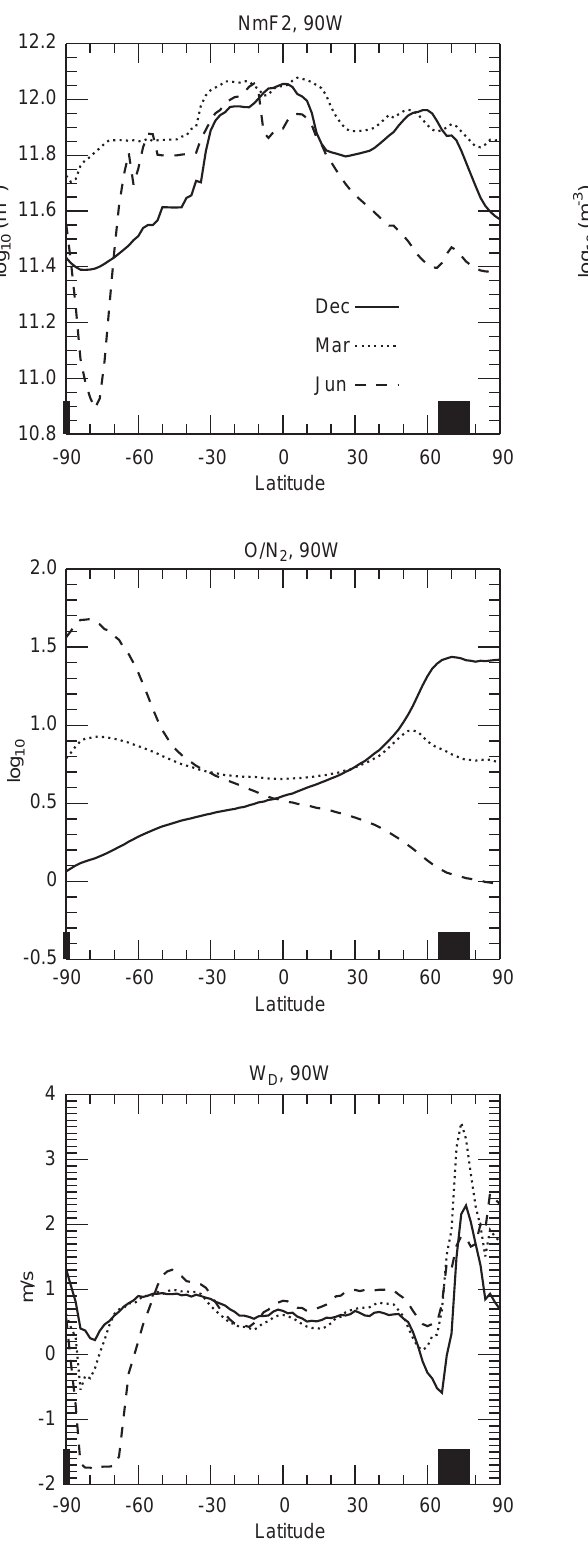
90 (cid:14) E and the southern oval at 90 (cid:14) W extend over the geographic pole into the opposite (midnight) meridian, so their full extent is not